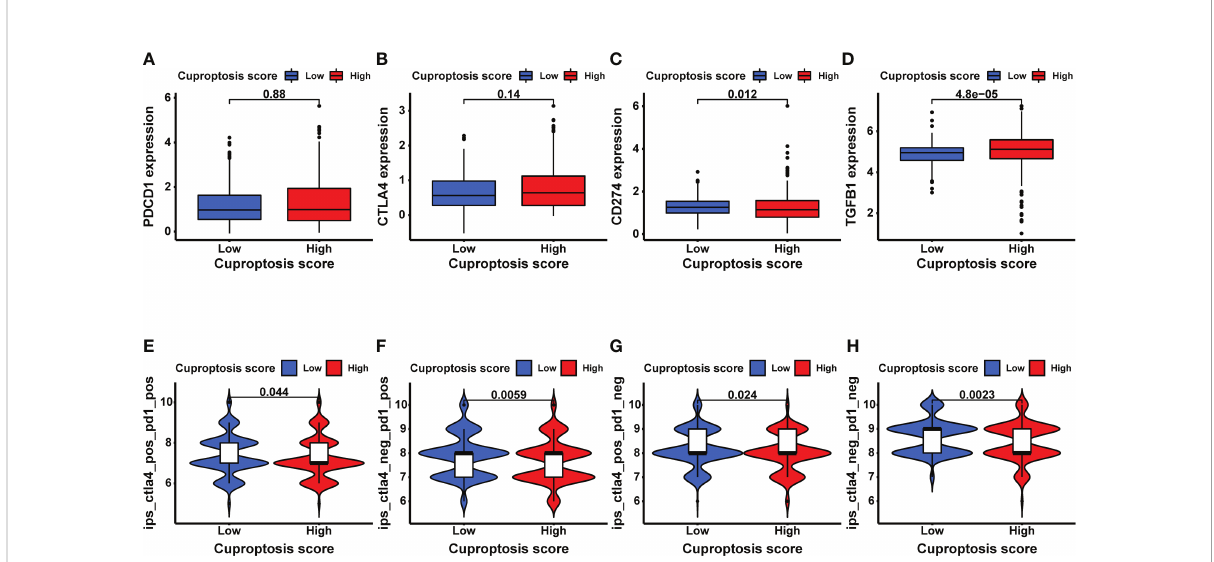
FIGURE 8 Exploratory analysis of immunotherapy based on CUS grouping. (A – D) The expression levels of immune target genes in different CUS groups: PDCD1 (A) , CTLA4 (B) , CD274 (C) and TGFB1 (D) . (E – H) The ef fi cacy of 4 ICIs was predicted by IPS scores from the TCGA-KIRC cohort in TCIA database: ctla4_pos_pd1_pos (E) , ctla4_neg_pd1_pos (F) , ctla4_pos_pd1_neg (G) and ctla4_neg_pd1_neg (H) . CUS, cuproptosis score; ICI: immune checkpoint inhibitor; IPS, immune cell proportion score; pos, positive; neg,